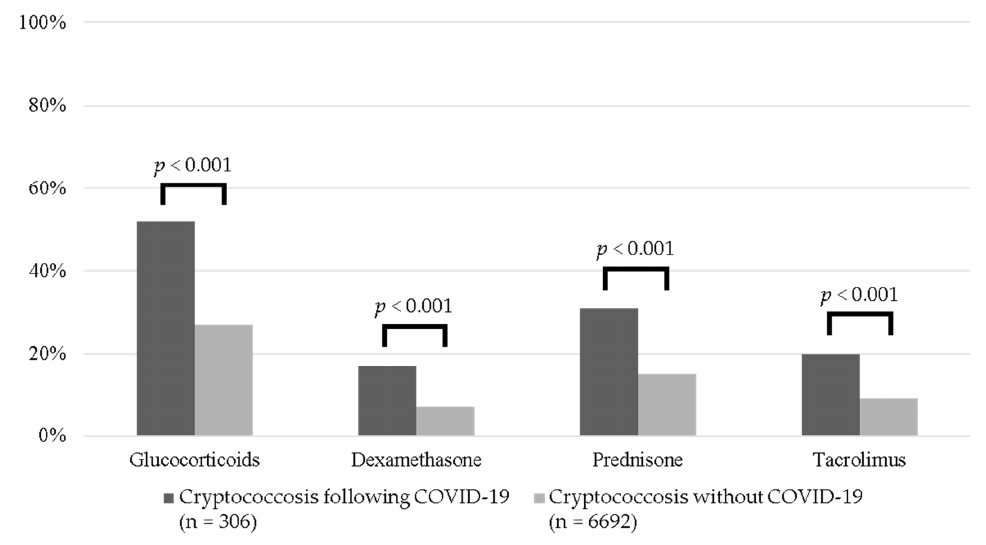
Figure 1. Proportion of patients who received immunosuppressive therapies among those with cryptococcosis following COVID-19 compared to non-COVID-19 controls with cryptococcosis.